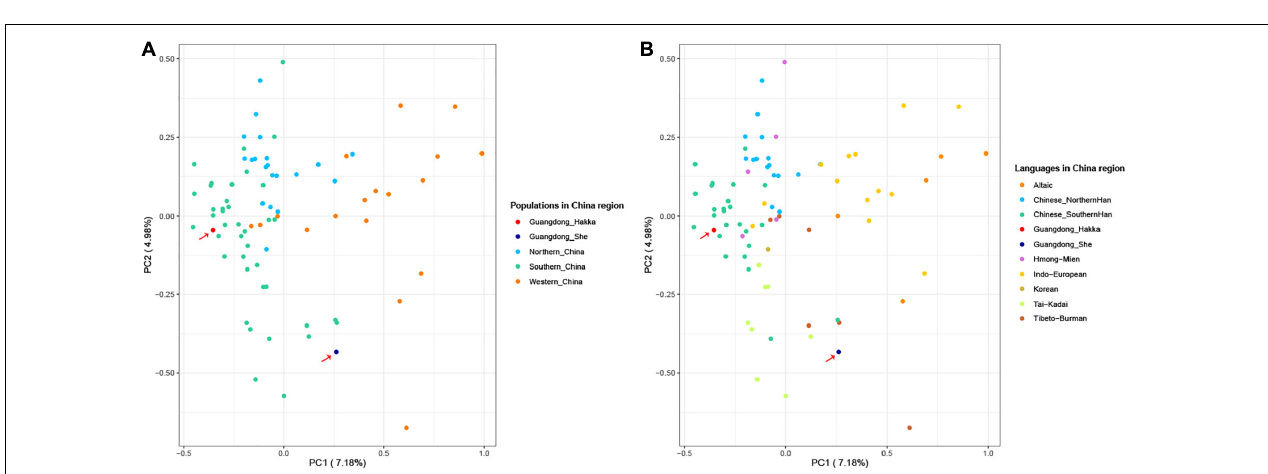
FIGURE 2 | Principal component analysis (PCA) based on the frequencies of 23 Y-STRs among Guangdong Hakka, Guangdong She, and 159 worldwide human populations. (A) PCA from geographical scale. (B) PCA from linguistic scale.